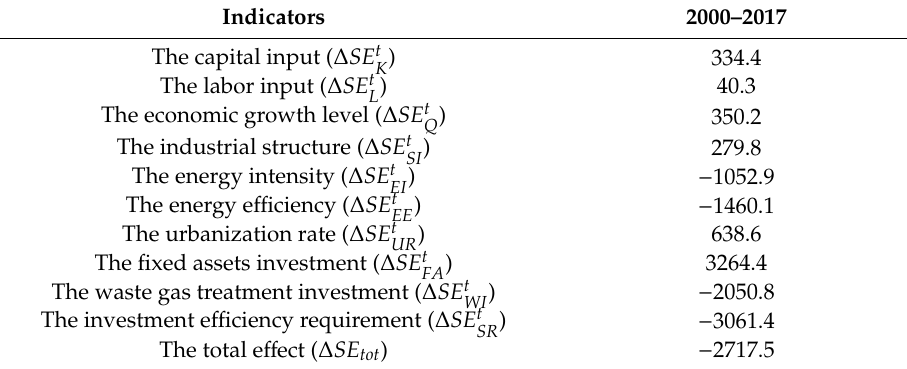
Table 6. The overall influencing factors decomposition in